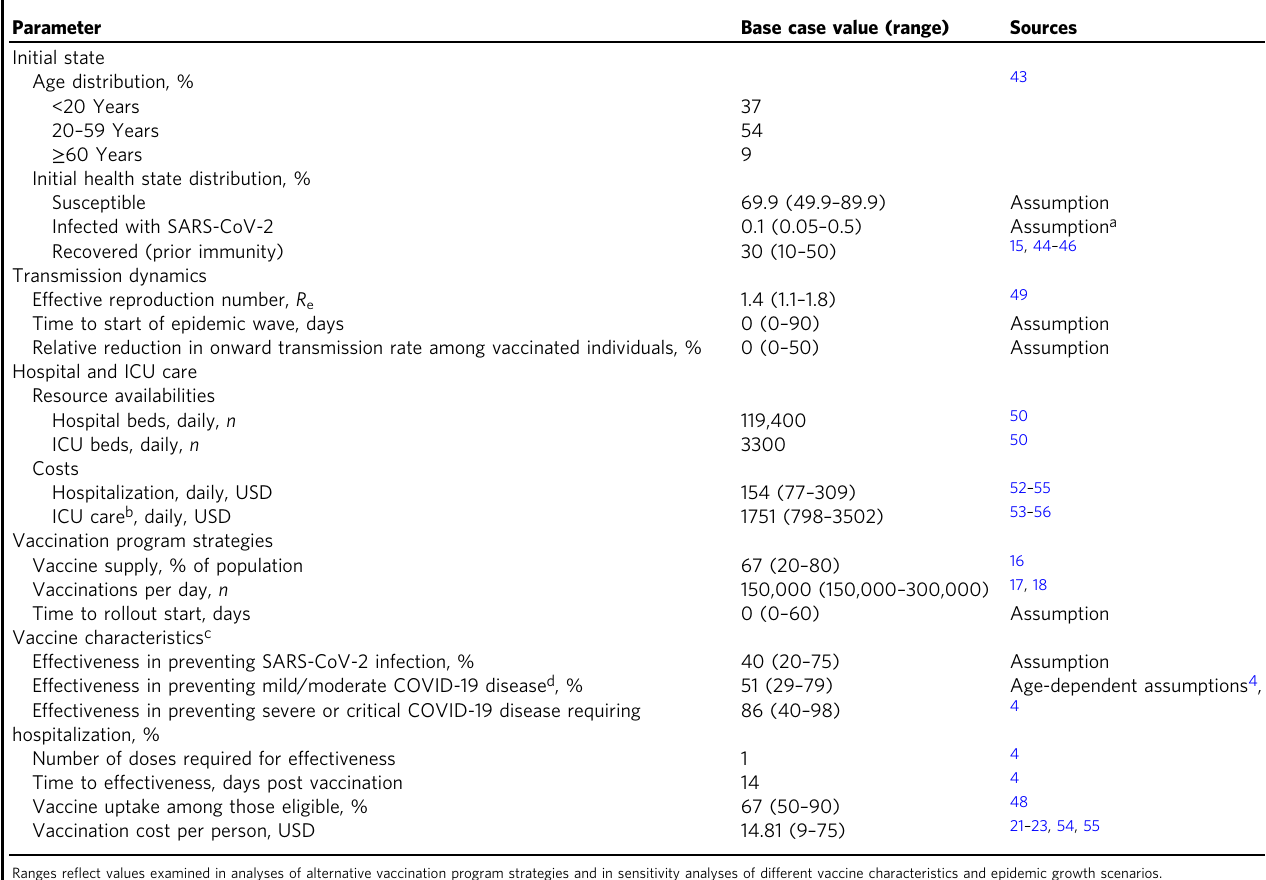
Table 3 Input parameters for a model-based analysis of COVID-19 vaccination in South